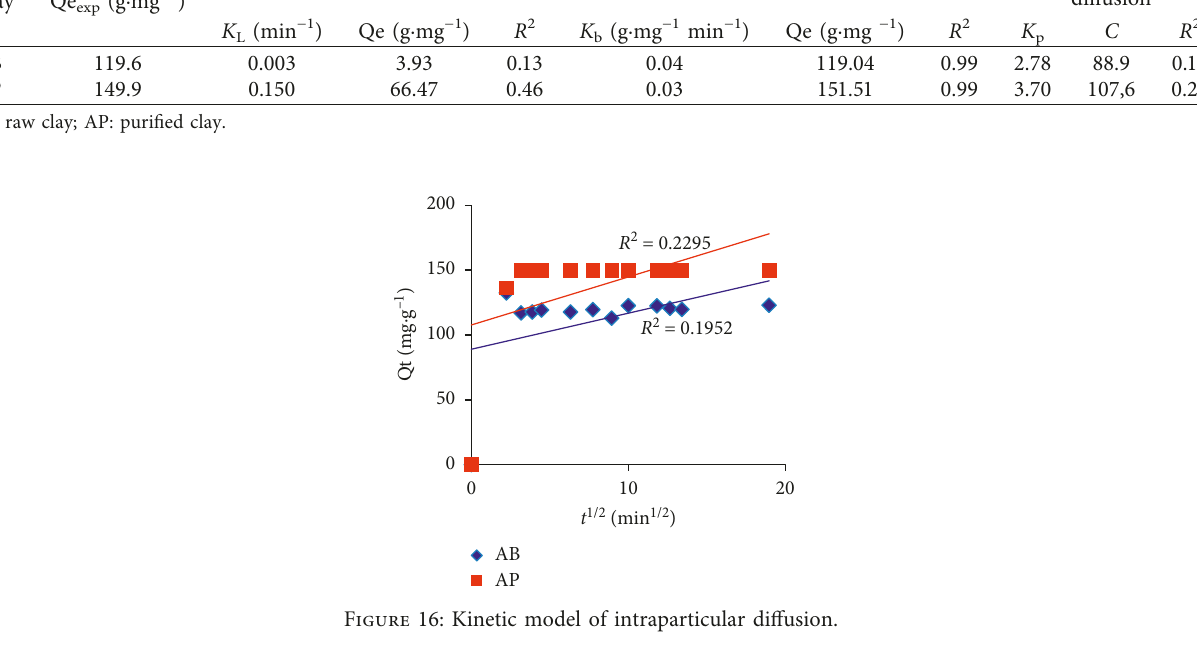
Figure 15: Application of the Lagergren (a) and Blanchard (b) models for the adsorption of methyl green by Sejnane clay. Table 5: Kinetic parameters of adsorption of methyl green on Sejnane Clay. Clay Qe exp (g · mg − 1 )